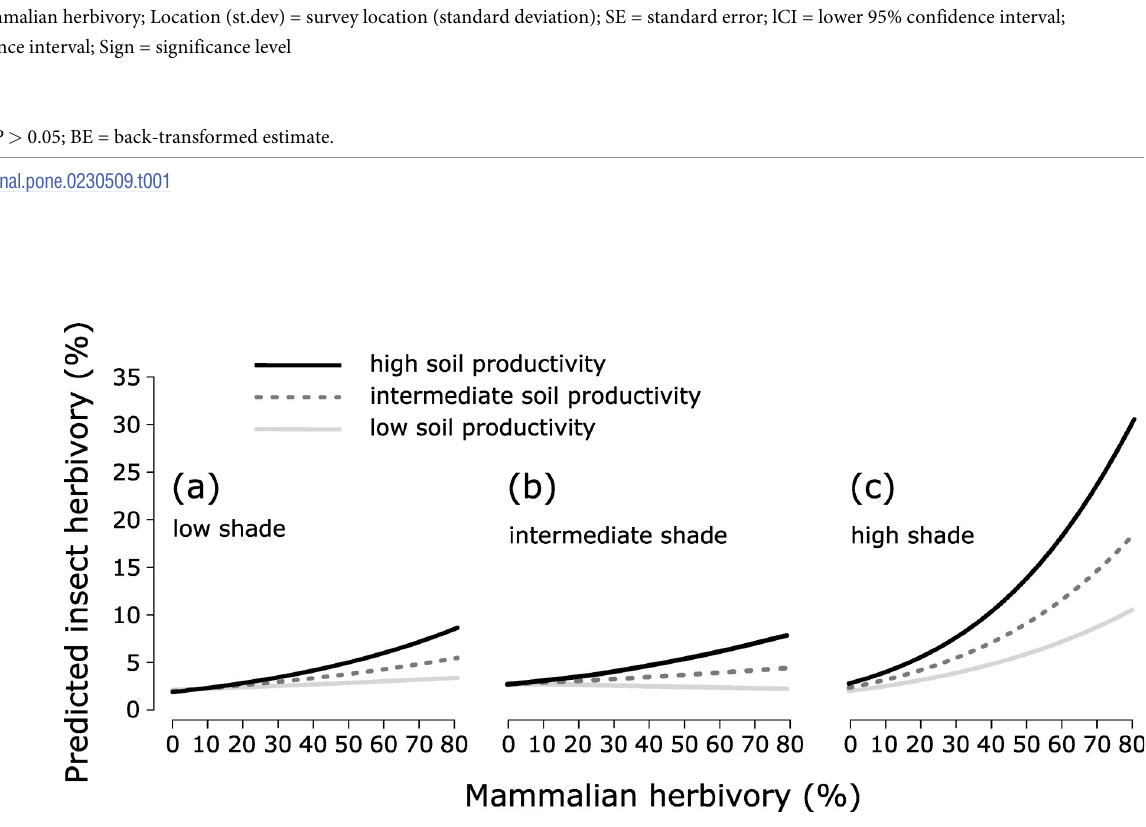
Fig 5. Predicted insect herbivory on bilberry leaves following mammalian herbivory. Predicted insect herbivory on bilberry ( Vaccinium myrtillus ) leaves, growing at low, intermediate and high soil productivity levels, as a function of previous mammalian herbivory in 2014, under conditions of (a) low, (b) intermediate and (c) high shade levels. Predictions based on parameter estimates for the best model (Table 1).